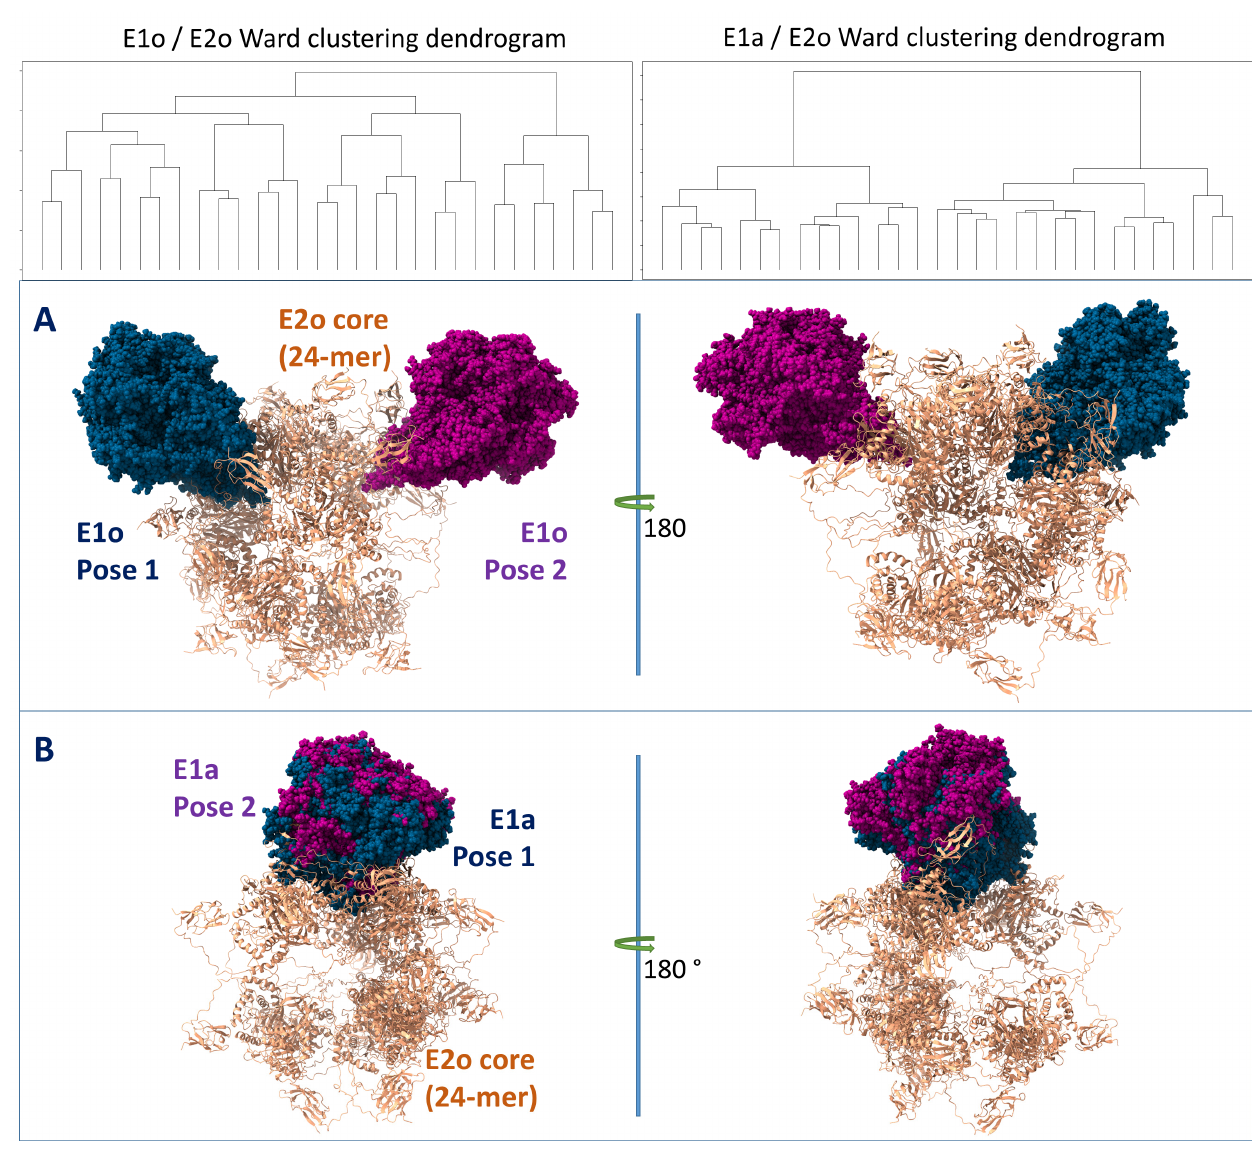
Figure 2. The best docking orientations for the binary subcomplexes hE1o-hE2o and hE1a-hE2o. (Top) Ward clustering dendrograms for the two subcomplexes. ( A ) Model docking for hE1o and hE2o. ( B ) Model docking for hE1a and hE2o. Model docking was performed in the Schrödinger program suite [37]. The AlphaFold Protein Structure Database was used for hE1o (ID: Q02218-F1) (https://alphafold.ebi.ac.uk/search/text/AF-Q02218-F1 (accessed on 12 September 2021)) and hE2o (P36957-F1) (https://alphafold.ebi.ac.uk/search/text/AF-P36957-F1 (accessed on 12 September 2021)). The reported X-ray structure of hE1a (PDB ID: 6U3J [35]) was used.